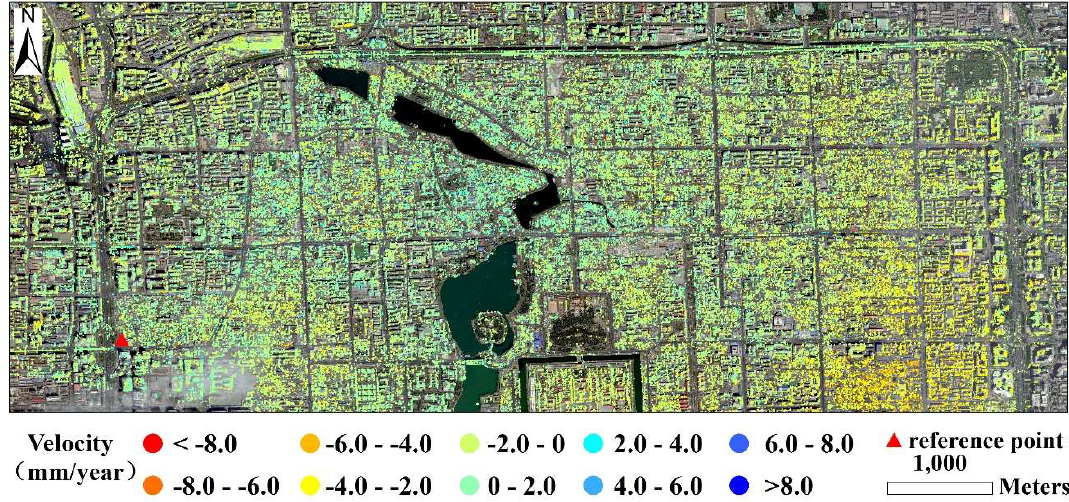
Figure 14. COSMO-SkyMed PSP InSAR mean velocity measurements in an area of Beijing, China.